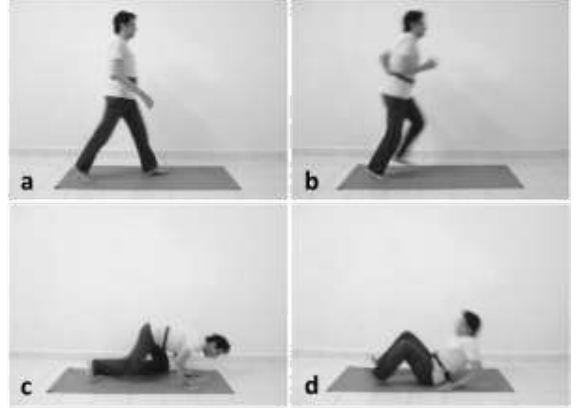
Fig. 3. Different types of ADL and fall experiments a. Walking, b. Running, c. Fall forward, d. Fall backward